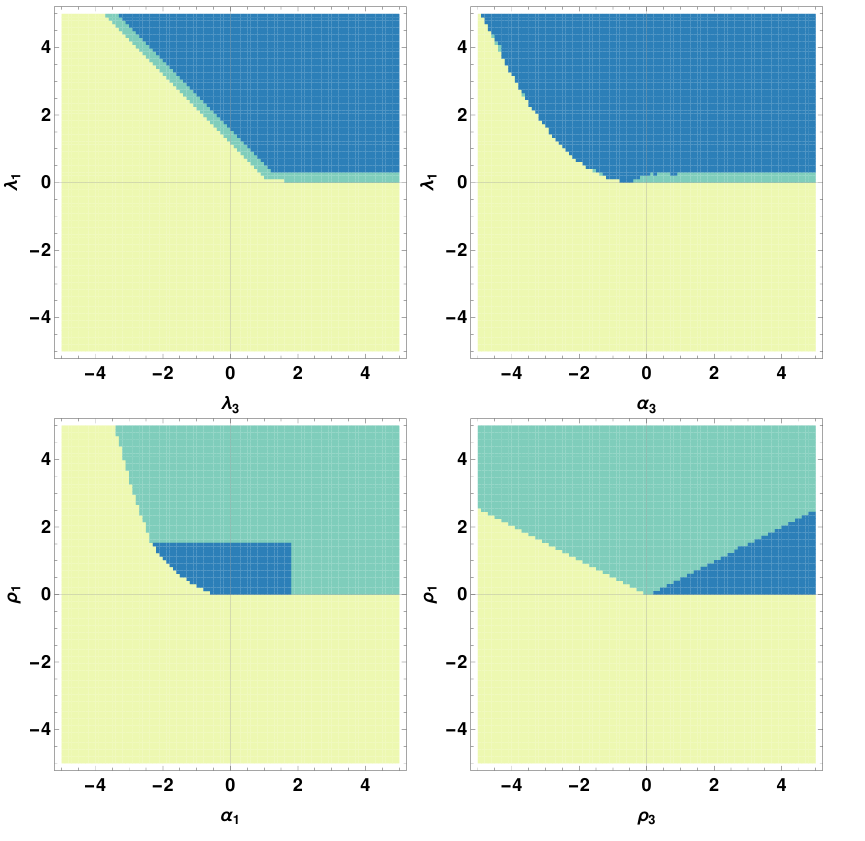
Figure 2 . Numerical minimization of the scalar potential of LRSM. The (cid:12)gures are plotted for di(cid:11)erent pair of quartic couplings with values ranging from ( (cid:0) 5 ; 5) and with grid pixel size of 0 : 1 (cid:2) 0 : 1, with other quartics being set according to benchmark in section 6. The yellow region indicates an unbounded potential. The green region indicates the existence of a global minimum but not with the required VEV structure. The blue region indicates the existence of a global minimum with the required VEV